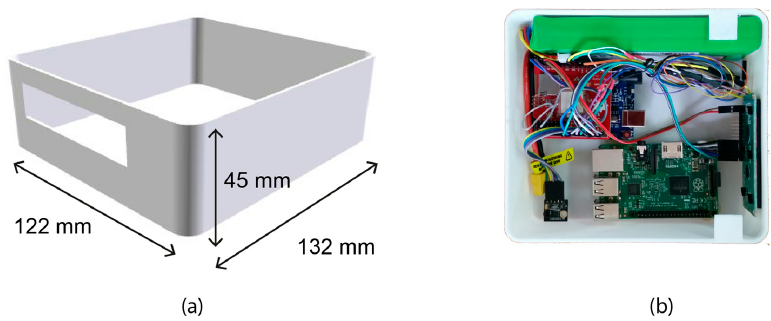
Figure 5. Polylactic acid (PLA) case: ( a ) Design of prototype and ( b ) Distribution of components. An UAV flight campaign over a CSP plant was executed with two objectives: to verify that the system works properly, and to test different altitudes Above Ground Level (AGL) and cruising speeds to define the specifications for use. A quadrocopter, model MD4-1000 (Microdrones GmbH, Siegen, Germany), was used as the UAV to perform the flights above the La Africana PTC CSP plant, located in Córdoba, Spain (CSP plant details in [56]) (Figure 6a). This CSP plant has 104 km of absorber tubes distributed on the surface. Currently, at this CSP plant, a thermographic inspection is performed by a technician with a thermal gun walking through the solar field and inspecting the absorber tubes. Once a problem is detected, the incident and its location are noted. With this methodology, an inspection takes one week for an expert technician and two if the inspection is done by a junior technician, and is only performed once a month or every two months. These numbers highlight the ineffectiveness of the method.